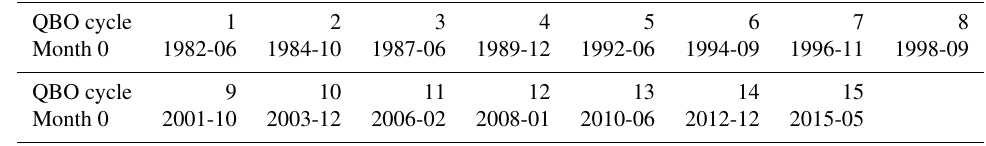
Table 1. The QBO composite dates (month 0).